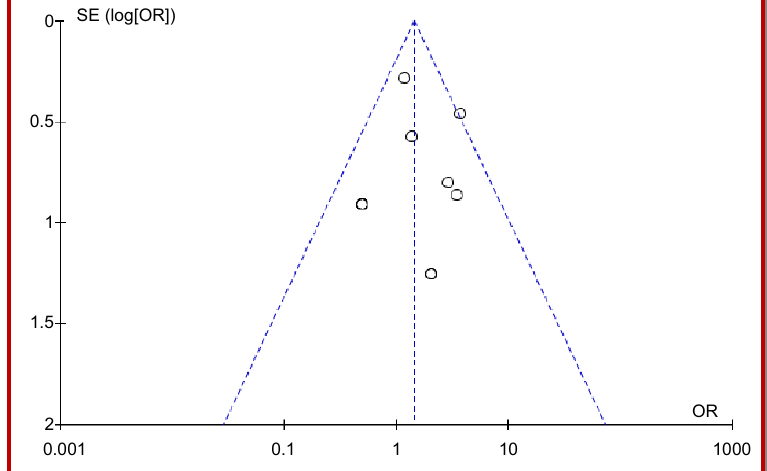
Figure 5. Funnel picture of bias involving comparison of effective rate of